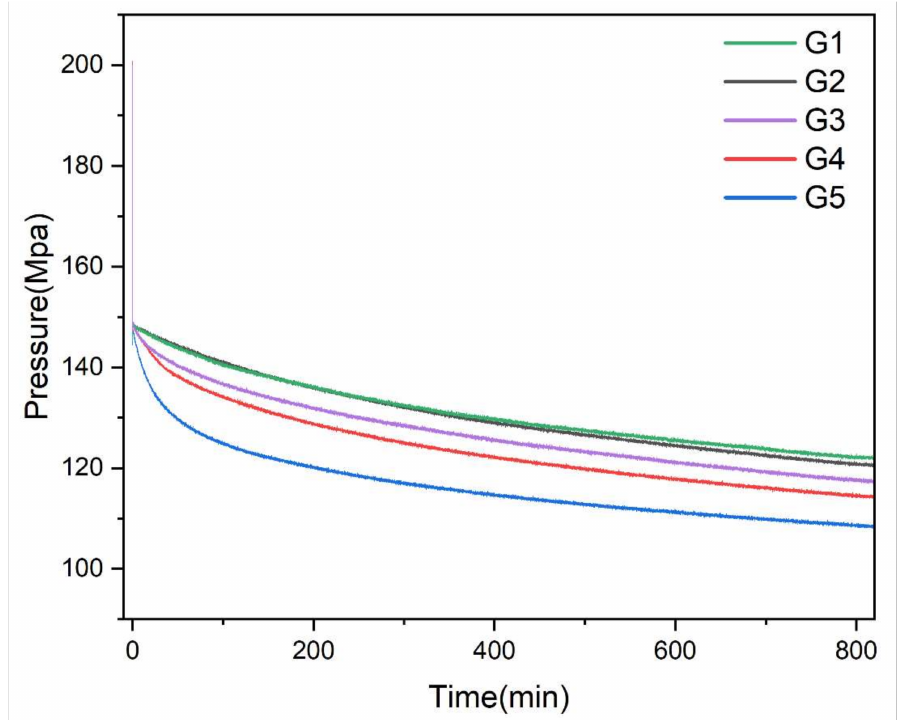
Figure 10. Hydrogen absorption test curves of G1, G2, G3, G4, and G5 samples in pure hydrogen.